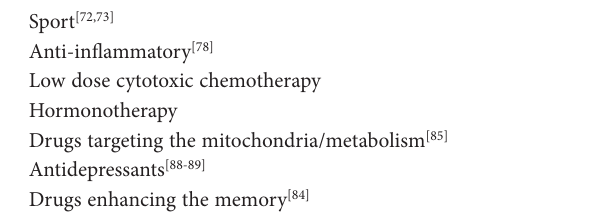
Table 5. Drugs increasing the export of entropy in the form of